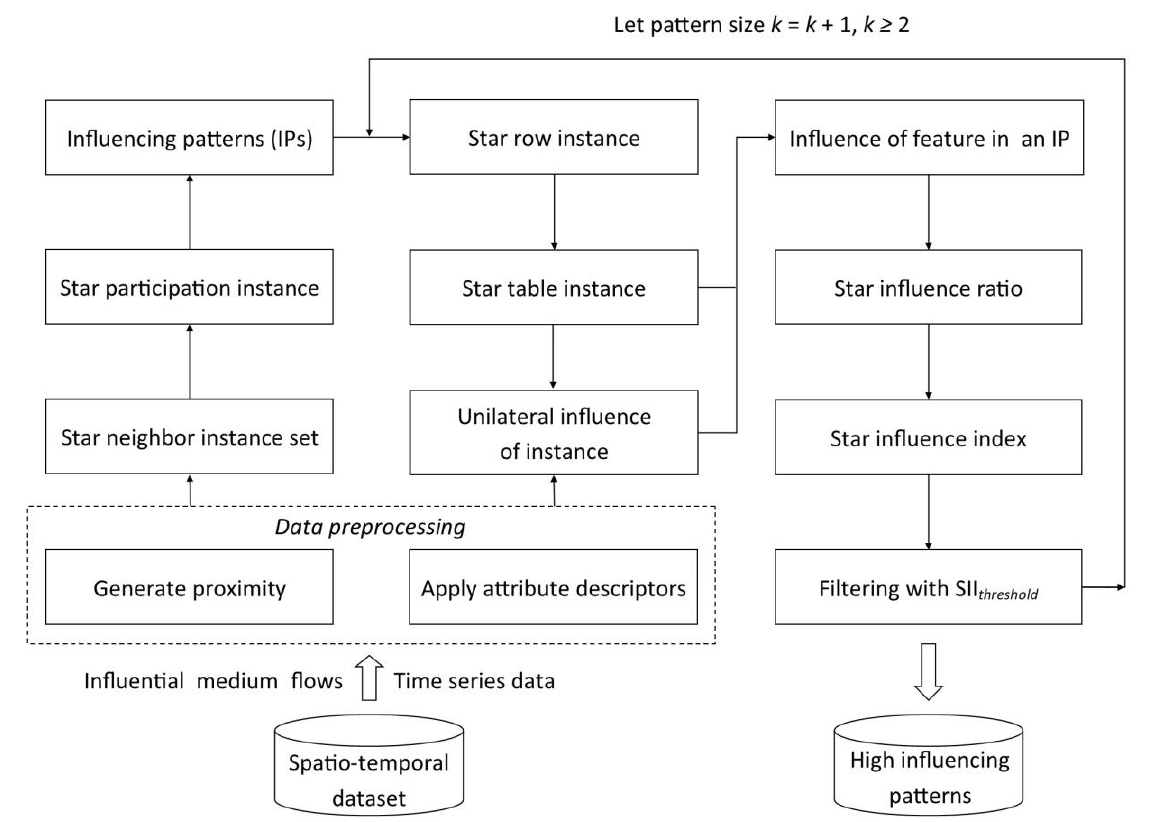
Figure 3. A proposed framework for mining high IPs.